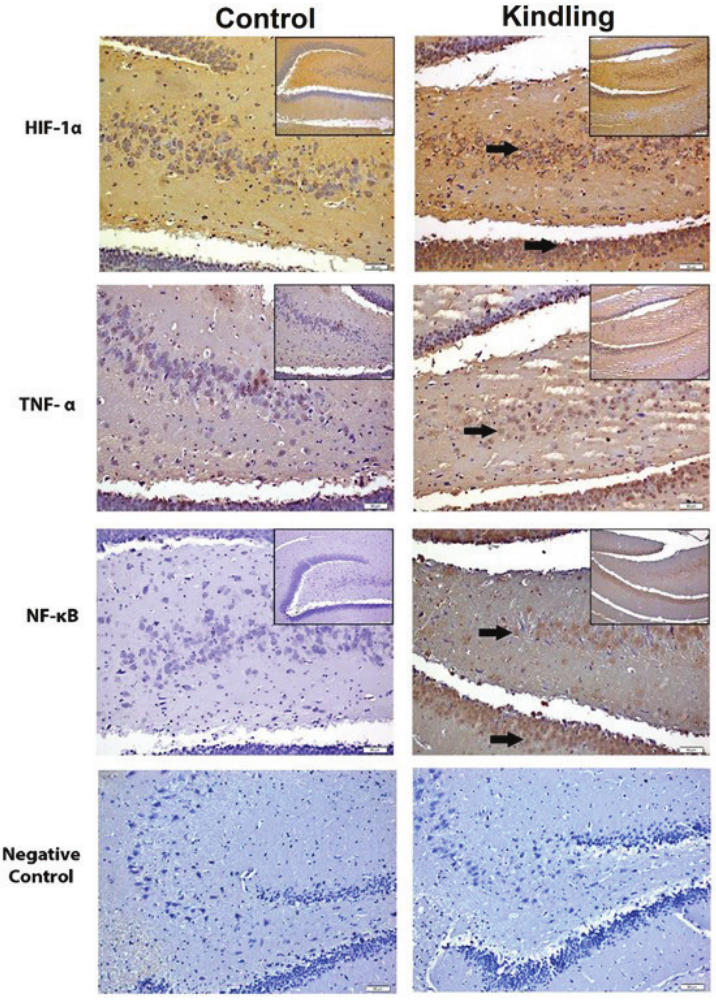
Fig. 3. Representative images of HIF-1α, TNFα, and NF-kB in the dorsal hippocampus of control rats and PTZ-kindling rats